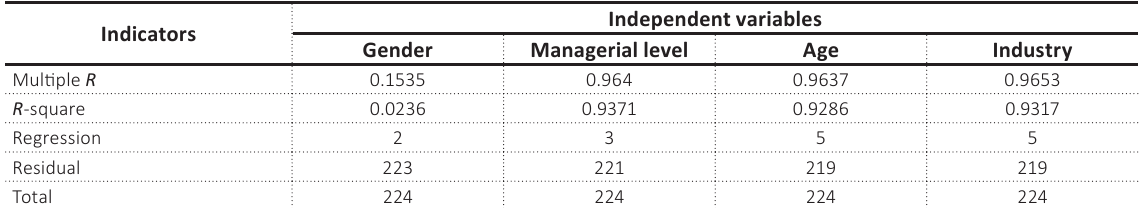
Table 5. Estimation of regression equations of the independent